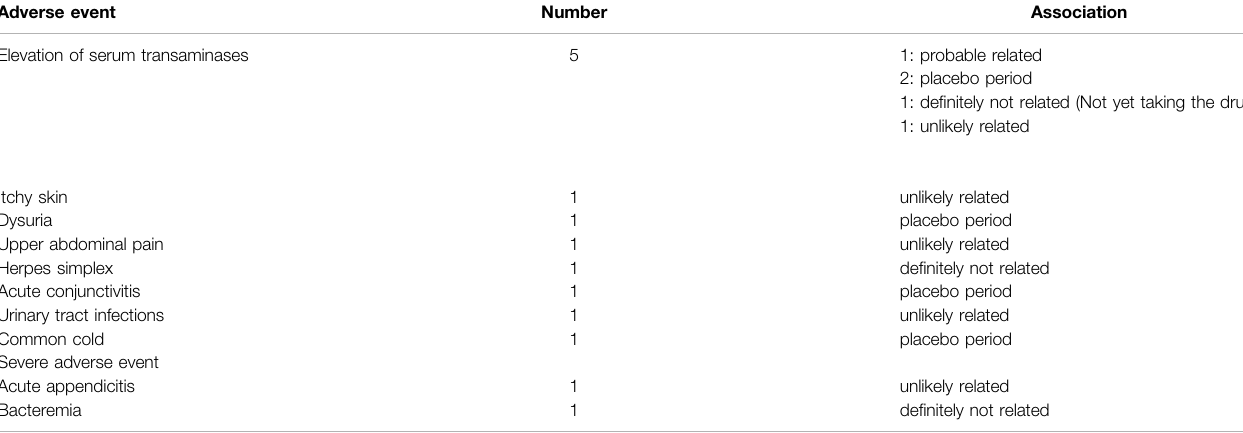
TABLE 3 | The adverse event and severe adverse events of the SS-1 trial for patients with Sjögren ’ s